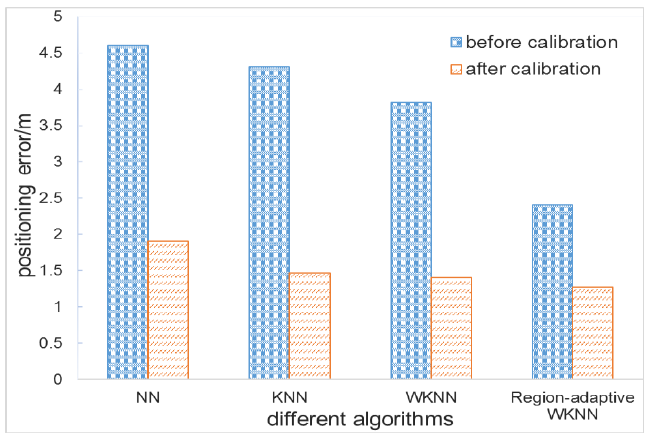
Figure 16. Comparison of average positioning error of different positioning algorithms before and after calibration.